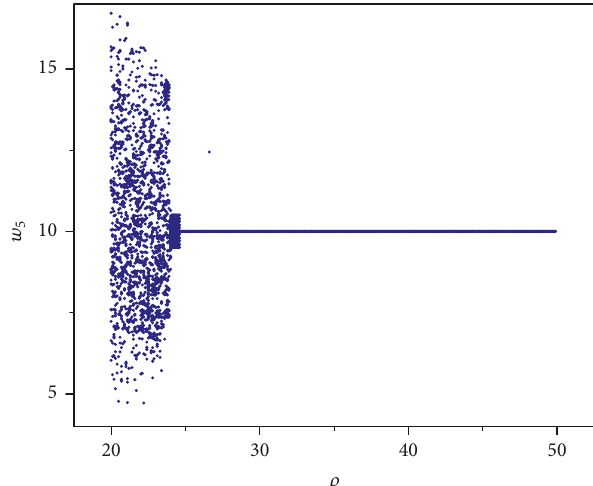
Figure2:Thebifurcationdiagramofsystem(3)whentheparameter 𝜌 is varying 𝜌 ∈ [20, 50]